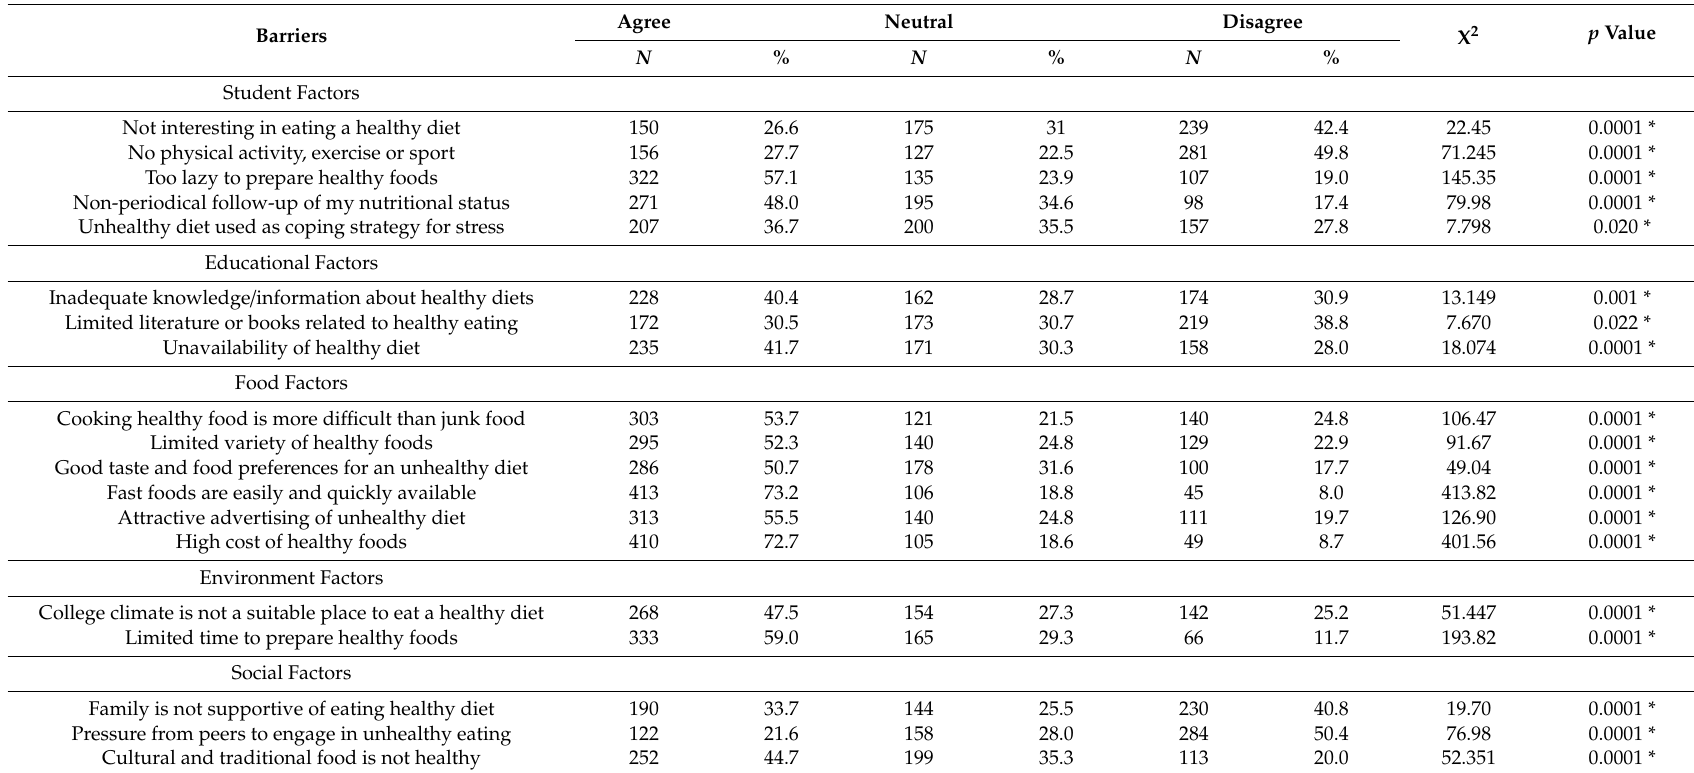
Table 4. Barriers to adherence to healthy eating among students ( n =